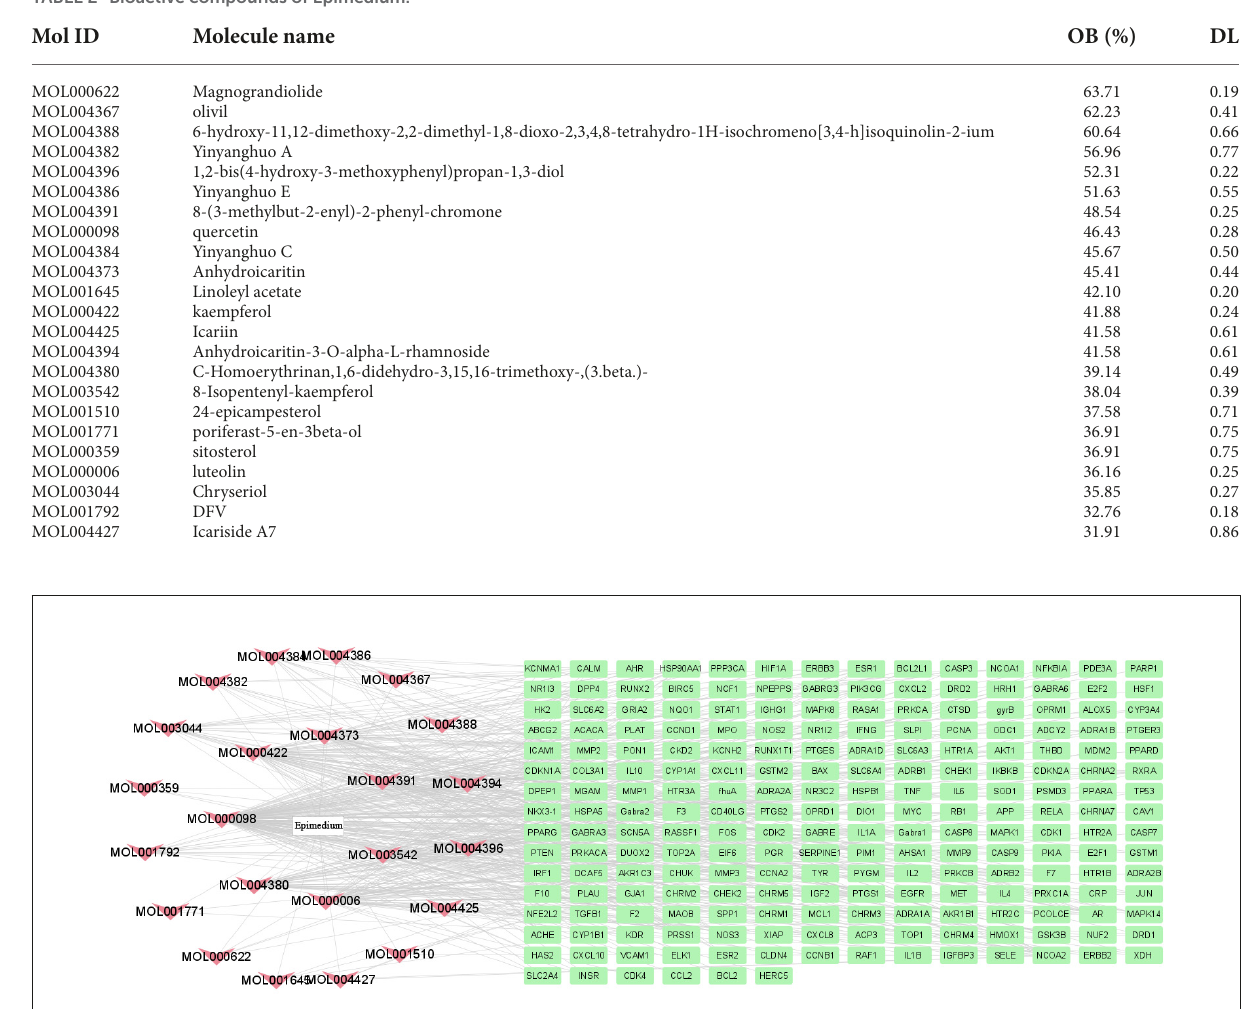
The top 15 cellular component (CC) terms identified